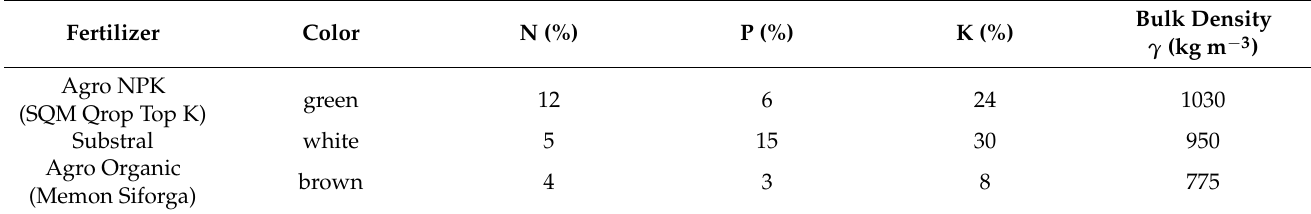
Table 1. The properties of blueberry